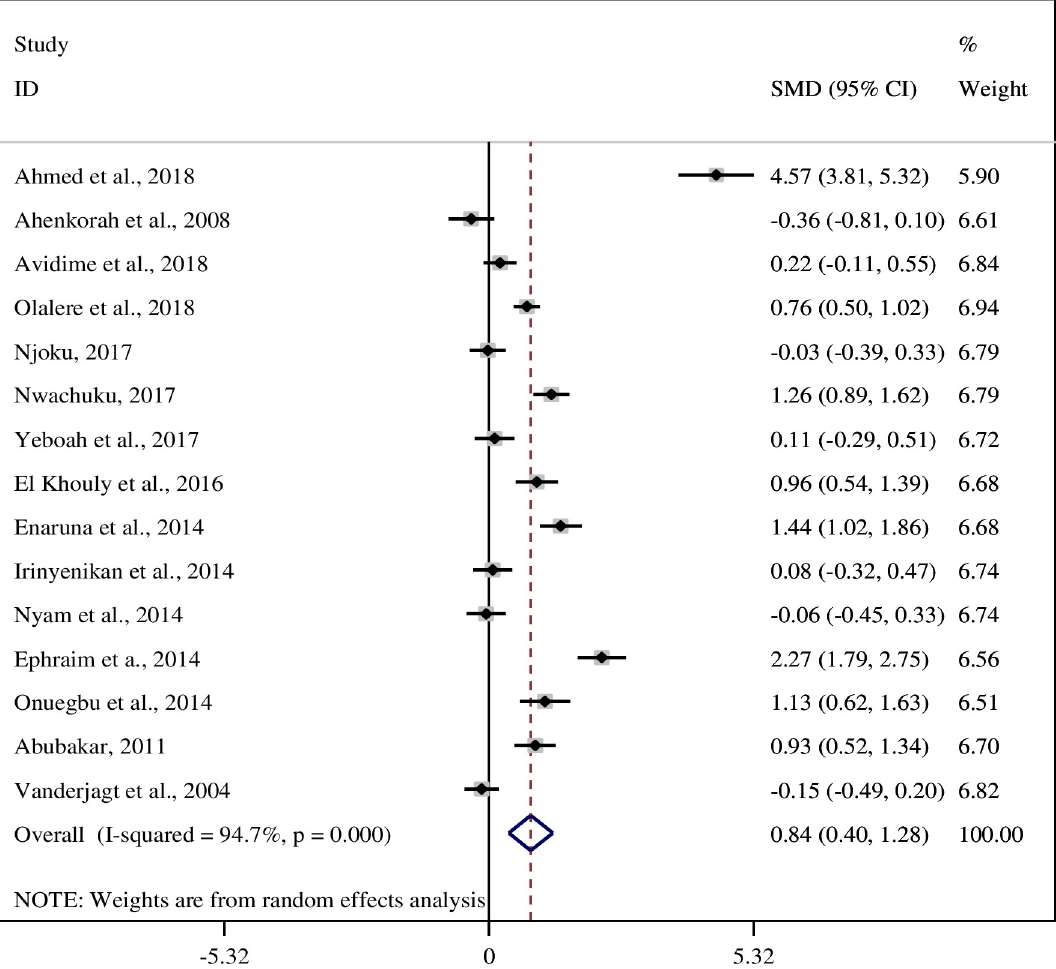
Fig 2. Forest plot of standardized mean difference of total cholesterol and